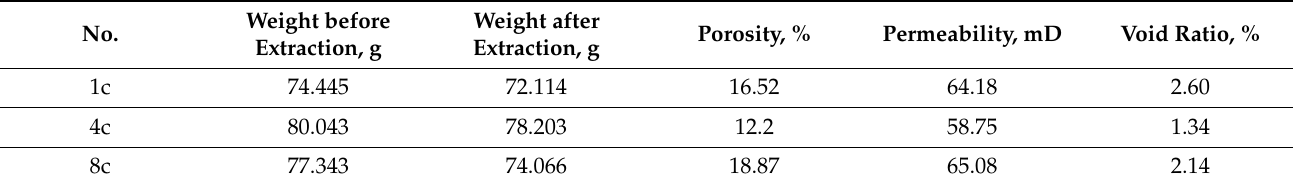
Table 7. Porosity, permeability, and void ratio of the extracted